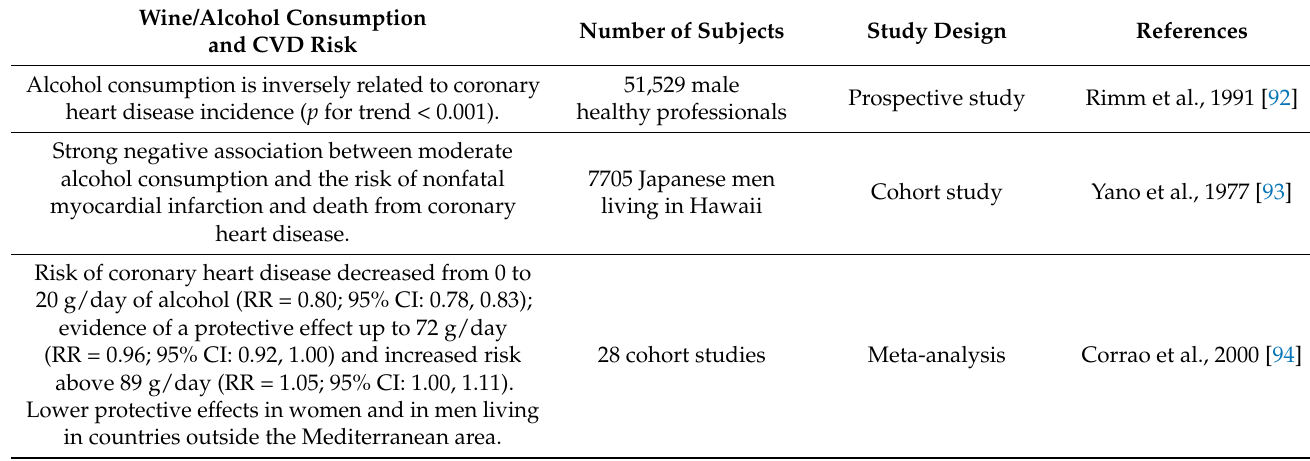
Table 1. Studies on wine consumption and risk of cardiovascular